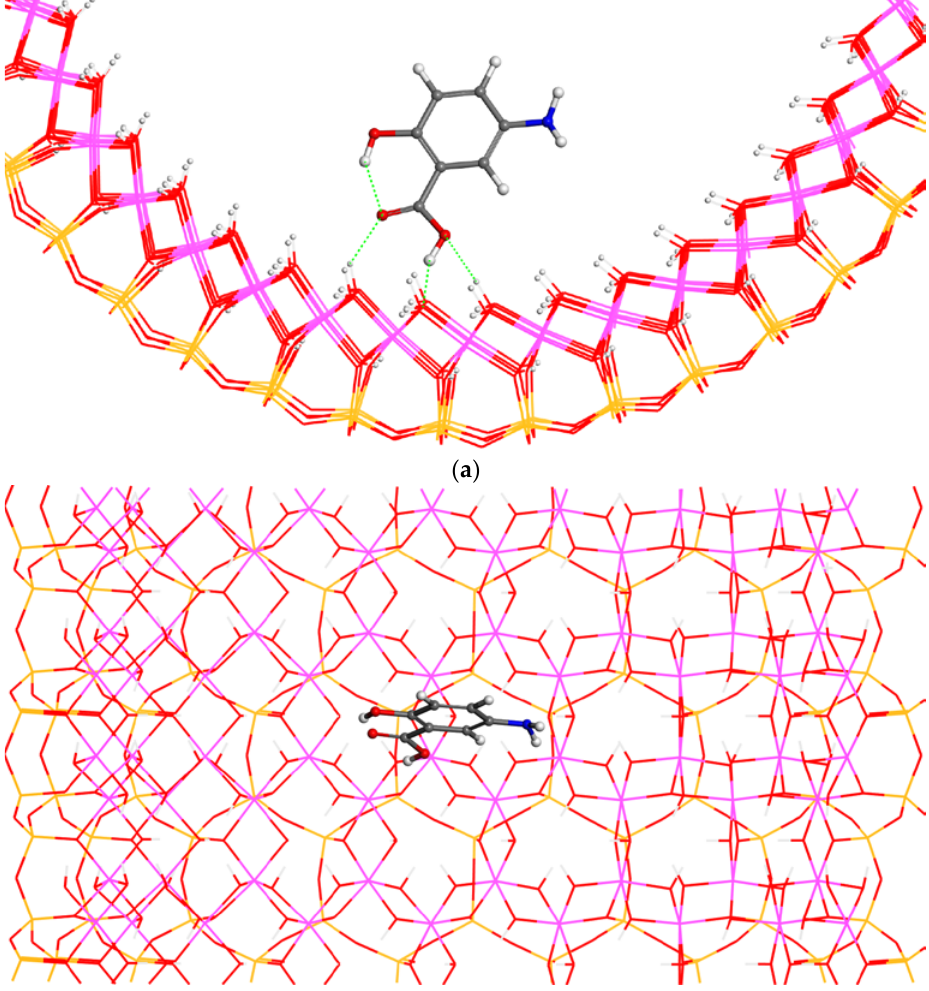
Figure 8. Adsorption of the conformer F2 of 5-ASA placed perpendicularly on the halloysite surface after its optimization. Views from the (001) ( a ) and (010) ( b ) crystallographic planes.